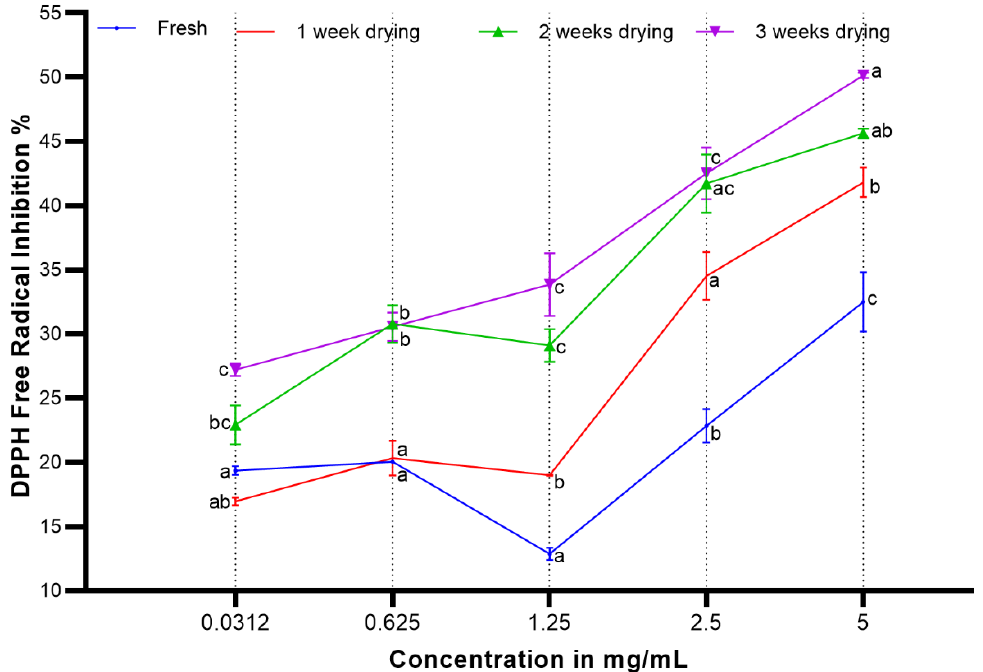
Figure 3. The antioxidant activity levels of rosemary oils agent DPPH-stable free radical tests for the fresh herbs (zero dryings), one-week, two-weeks, and the three-weeks dried herbs oil’s DPPH reactivity. The statistical significance of the two-way ANOVA was p < 0.0001. Tukey’s multiple comparisons were then performed for all the different concentrations. Different letters within the same concentration denote significant differences among the groups according to Tukey’s test ( p < 0.01).